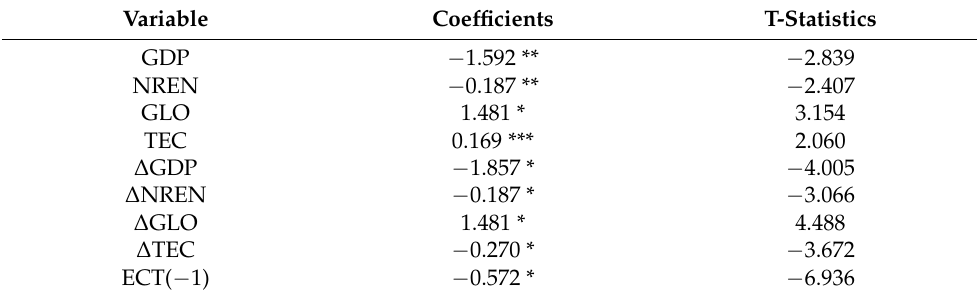
Table 6. ARDL estimator